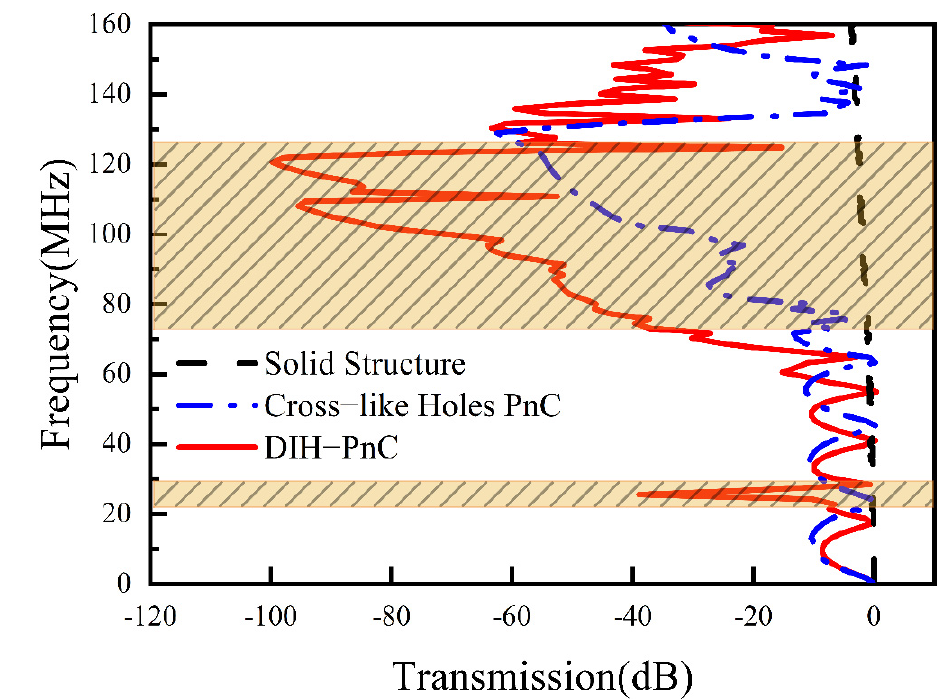
Figure 5. Delay line S 21 .The gray dashed line is the solid contrast delay line, the blue dotted line is the cross-like holey PnC delay line, and the red solid line is the DIH-PnC delay line. The shaded area is the band gap range in the x-direction.